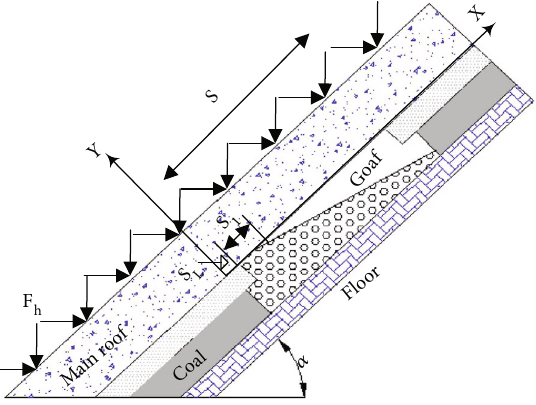
Figure 3: Model of inclined suspended roof structure.